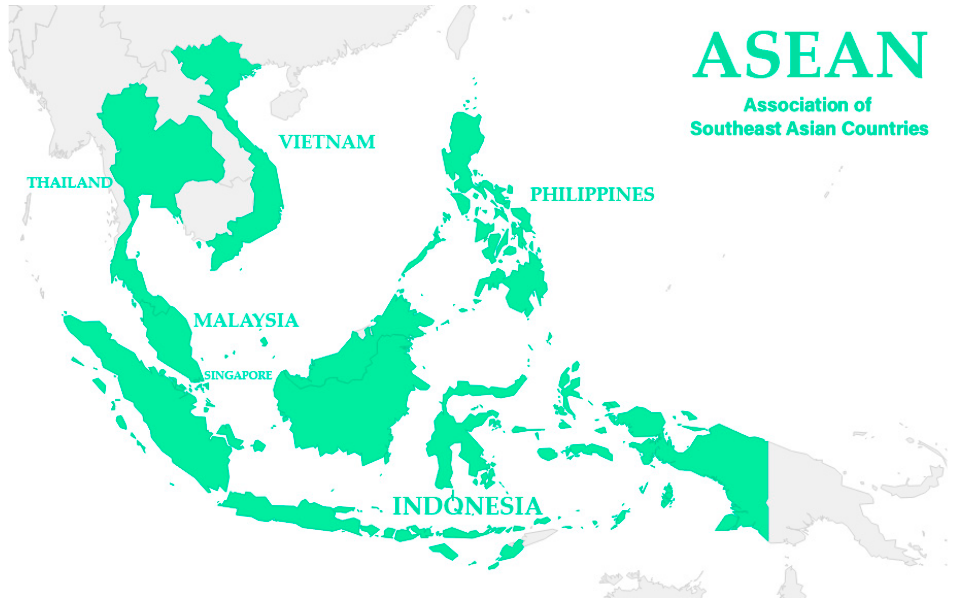
Figure 1. The study area map.